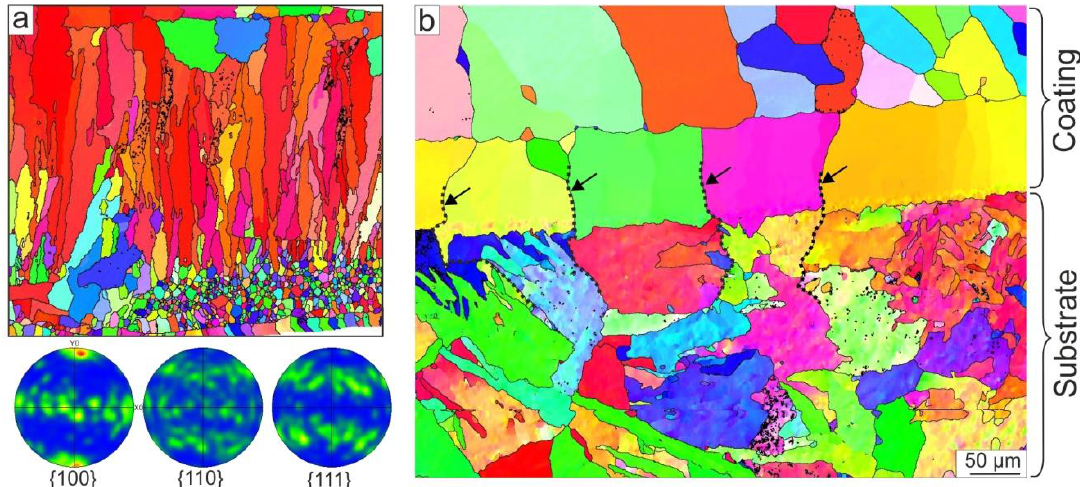
Figure 8. ( a ) IPF map of NiAl-based coating and pole figures of this area, illustrating the